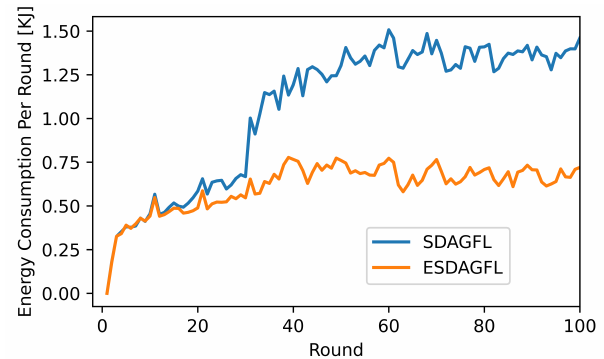
Figure 10. Energy consumption in every round evaluated on the FMNIST-clustered